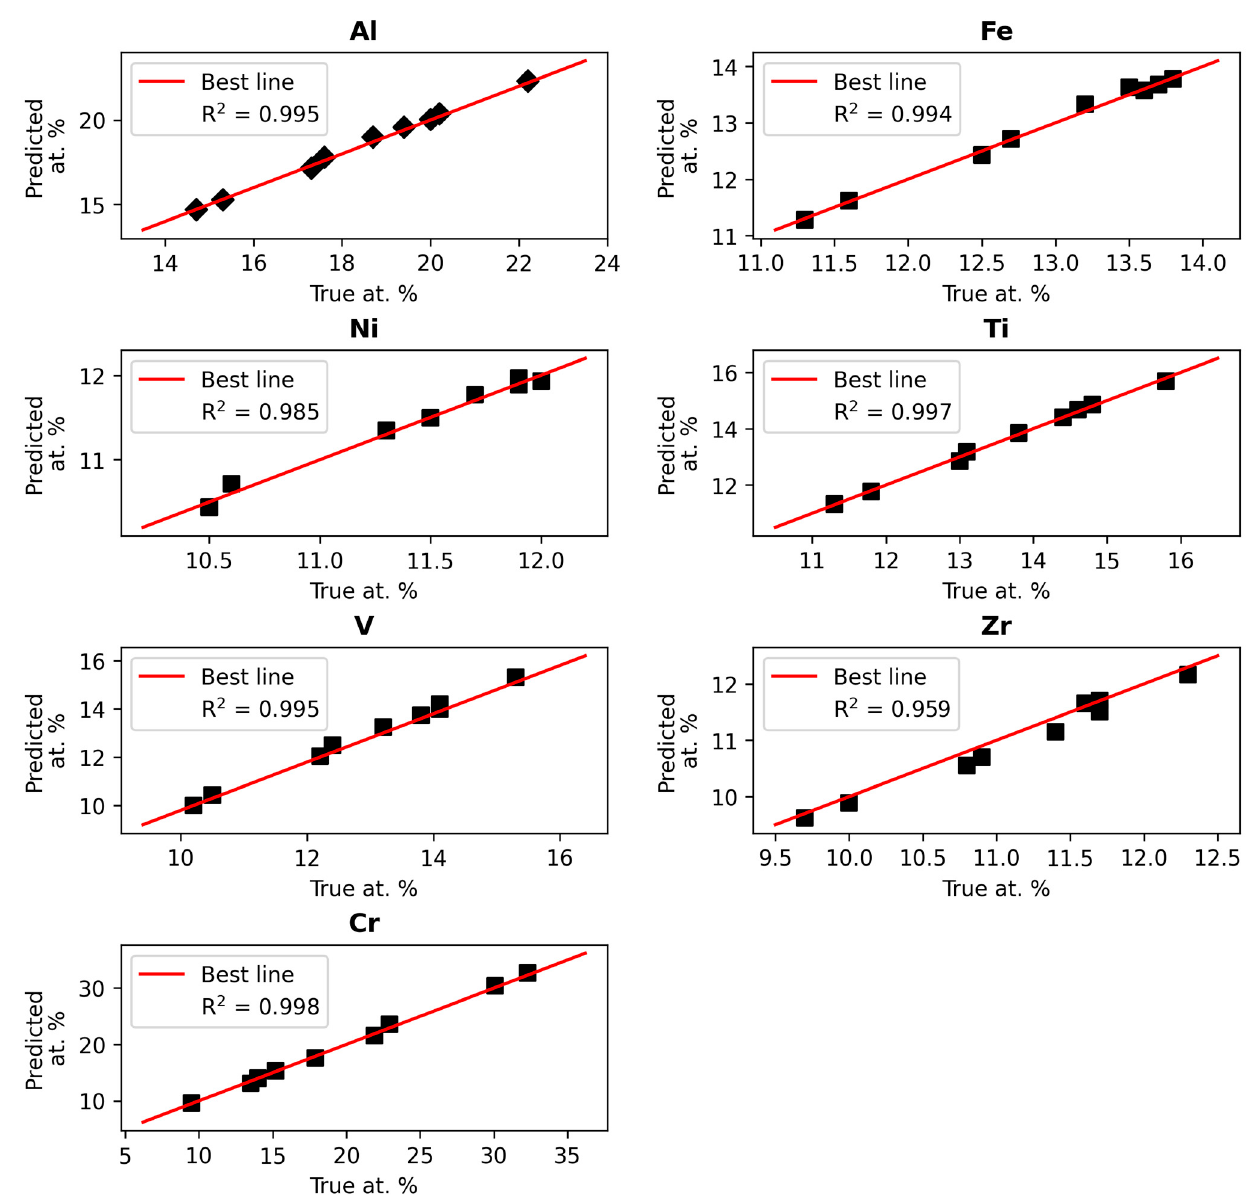
Figure 5. True and predicted values of elements’ atomic percentage computed by the random forest model.